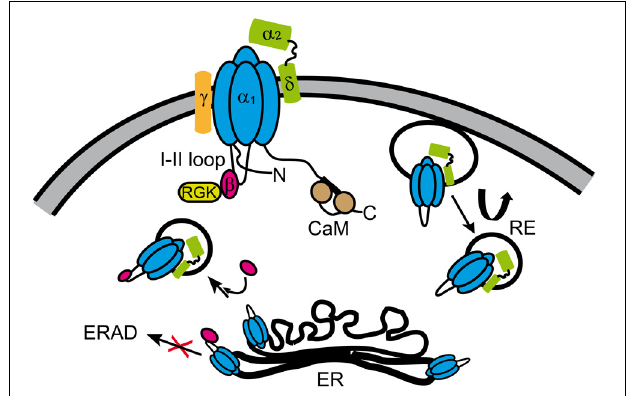
FIGURE 7 | Summary of proteins interacting with Ca V α 1 of HVA channels. HVA channels are heteromultimers consisting of at least three subunits ( α 1 , β , α 2 δ ), except for Ca V 1.1 class that also includes the γ -subunit. For clarity, the α 1 -subunit sketch includes only the intracellular loop joining the first and second repeat (loop I–II) that associates with the β -subunit. The α 2 δ - and β -subunits increase the electrical activity and the number of the channels in the plasma membrane. While the β -subunit enhances anterograde trafficking of channels likely retained in the ER, α 2 δ -subunit promotes recycling of channels (curved arrow). The β -subunit also prevents the channel to be targeted to the ERAD degradation complex from the ER. RGKs regulate channel function by multiple mechanisms upon binding to the channel complex through the β -subunit (see Figure 5 ). CaM is widely known for its effect on HVA calcium dependent inactivation and facilitation. The exact subunit composition of the channel in the different vesicular compartments is not known. CaM, calmodulin; RGK, RGK small GTPases; RE, recycling endosome; ER, endoplasmic reticulum; ERAD, endoplasmic reticulum-associated protein degradation